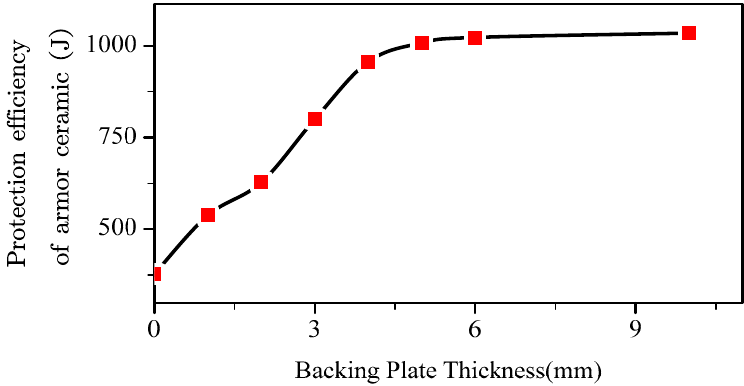
Figure 6. Energy dissipation of the armor ceramics at various back plate thicknesses.